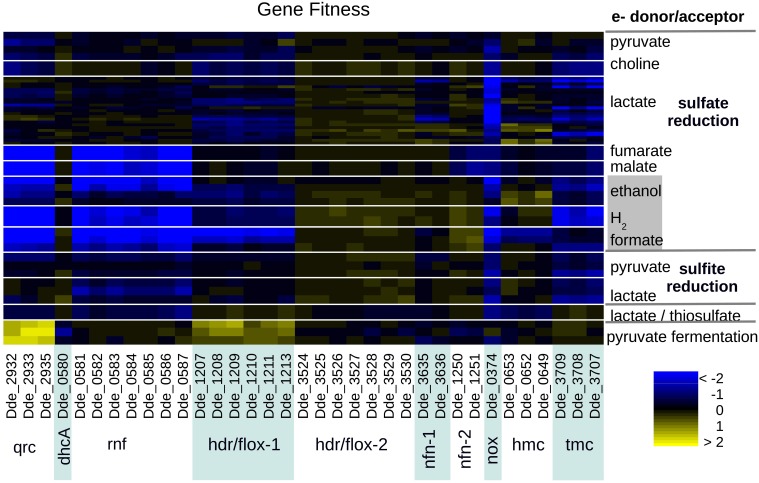
Heatmap of fitness data for central electron transport complexes across 12 energetic conditions. Experiments are ordered and cells are colored as in Figure 2.